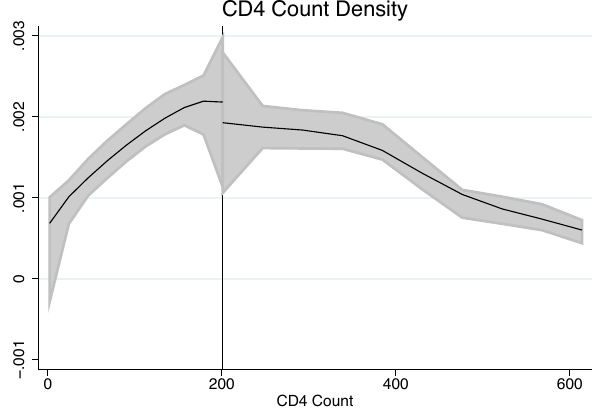
Figure 1. Estimated density of first CD4 counts with 95% confidence interval. The threshold lies at 200 CD4 cells/μl. The null hypothesis of a joint distribution could not be rejected (t = − 0.2028, p = 0.8393).